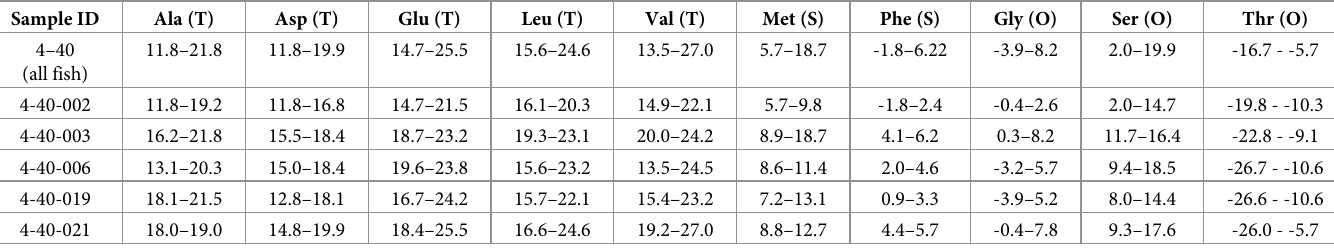
Table 3. Amino acid δ 15 N values ( δ , in ‰) for Red Snapper individuals from station 4–40.